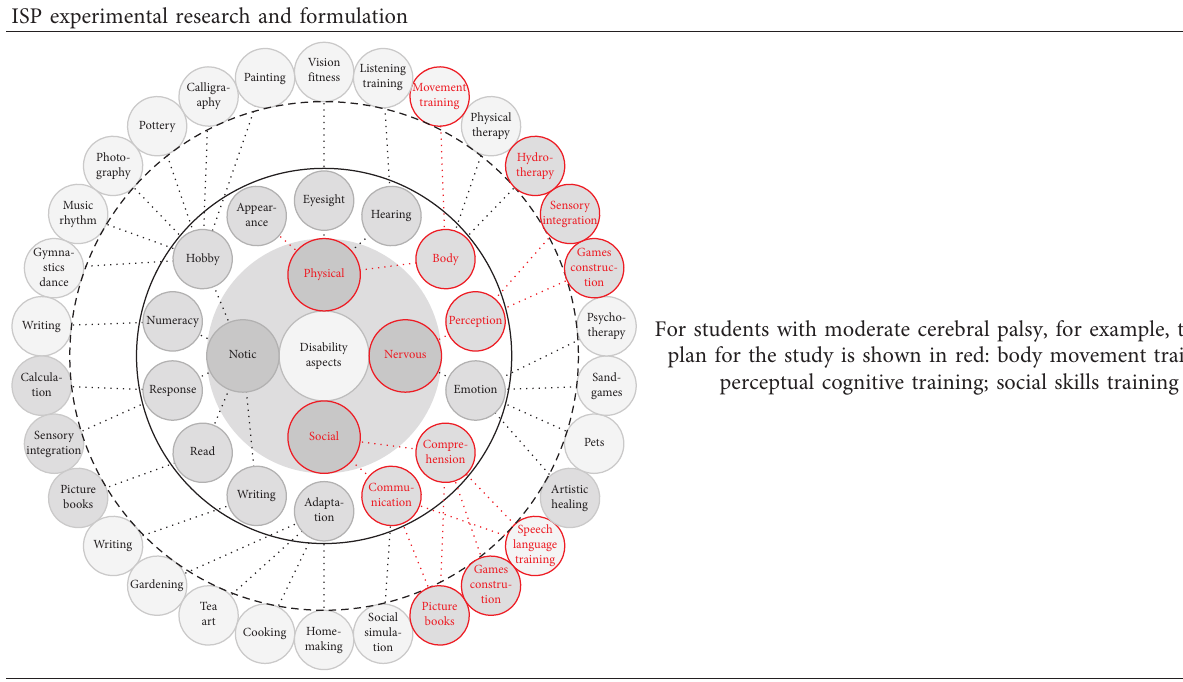
Table 4: ISP experimental research and planning roadmap.